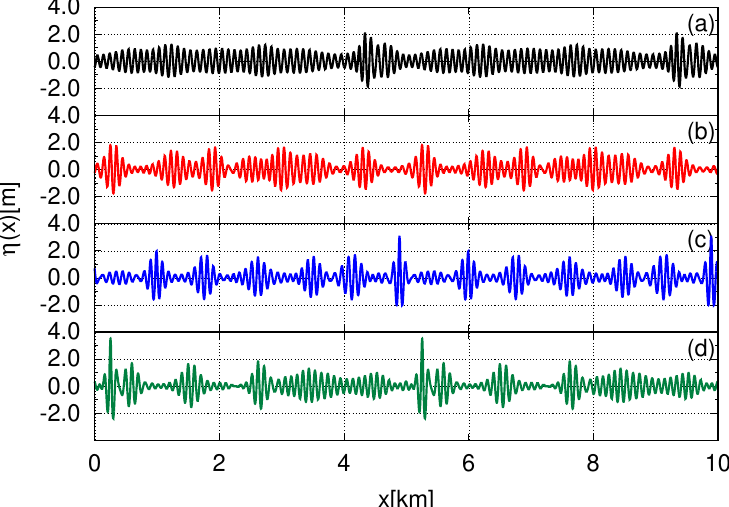
Figure 7. Simulations in the framework of the SCZ model at large times. Different panels show snapshots of the free surface at: ( a ) t ≈ 20.5 h ( b ) t ≈ 22.2 h ( c ) t ≈ 38.3 h and ( d ) t ≈ 53.8 h.